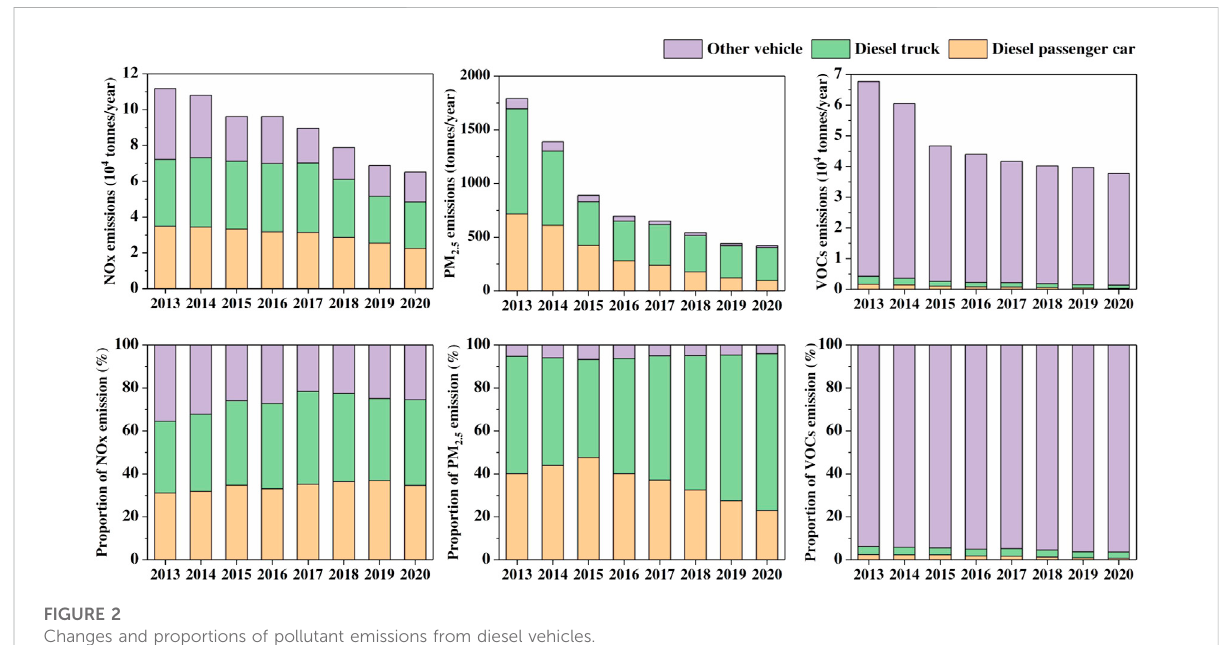
FIGURE 2 Changes and proportions of pollutant emissions from diesel vehicles.